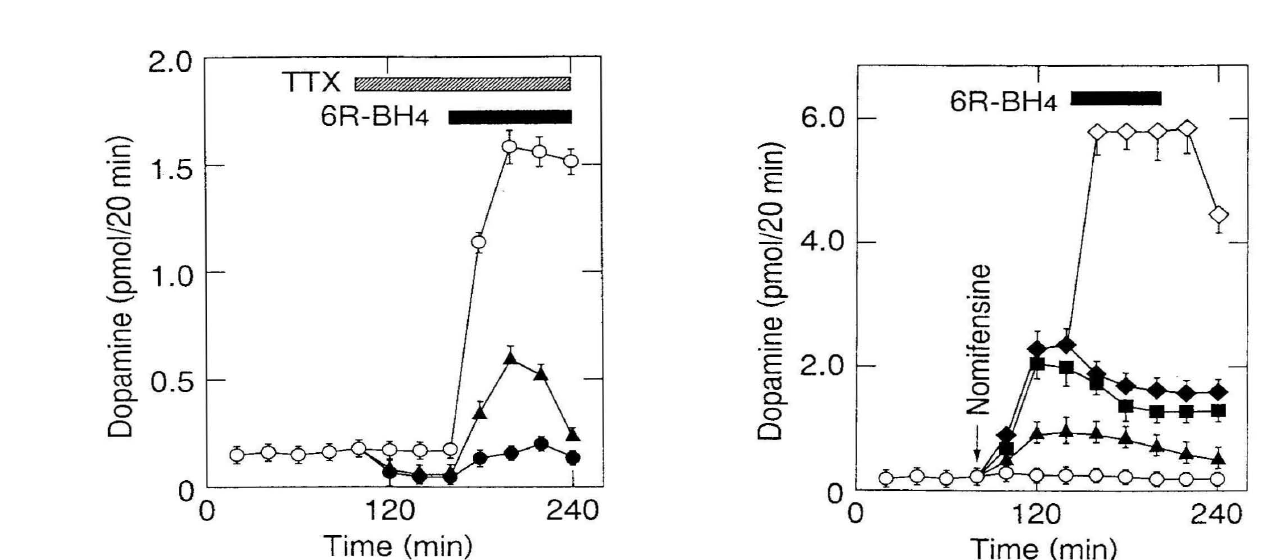
Figure 3. Effects of varying concentrations of tetro dotoxin (TTX) on 6R-BIL-induced increases in DA lev els in striatal dialysates. After DA levels in striatal di alysates reached a steady state, TTX was added to the perfusion fluid of rnicrodialysis probes at a final con centration of 20 ~ (filled triangles), or 50 j.1M (filled circles) during the time indicated by a hatched bar. Sixty minutes after addition of TTX , 6R-BIL was added to the perfusion fluid at a final concentration of 1 mM as in dicated (a black bar). Empty circles represent the control group, which was gi\'en 6R-BH., alone. Each value is the mean ± SE1\.1 of to ur determinations.